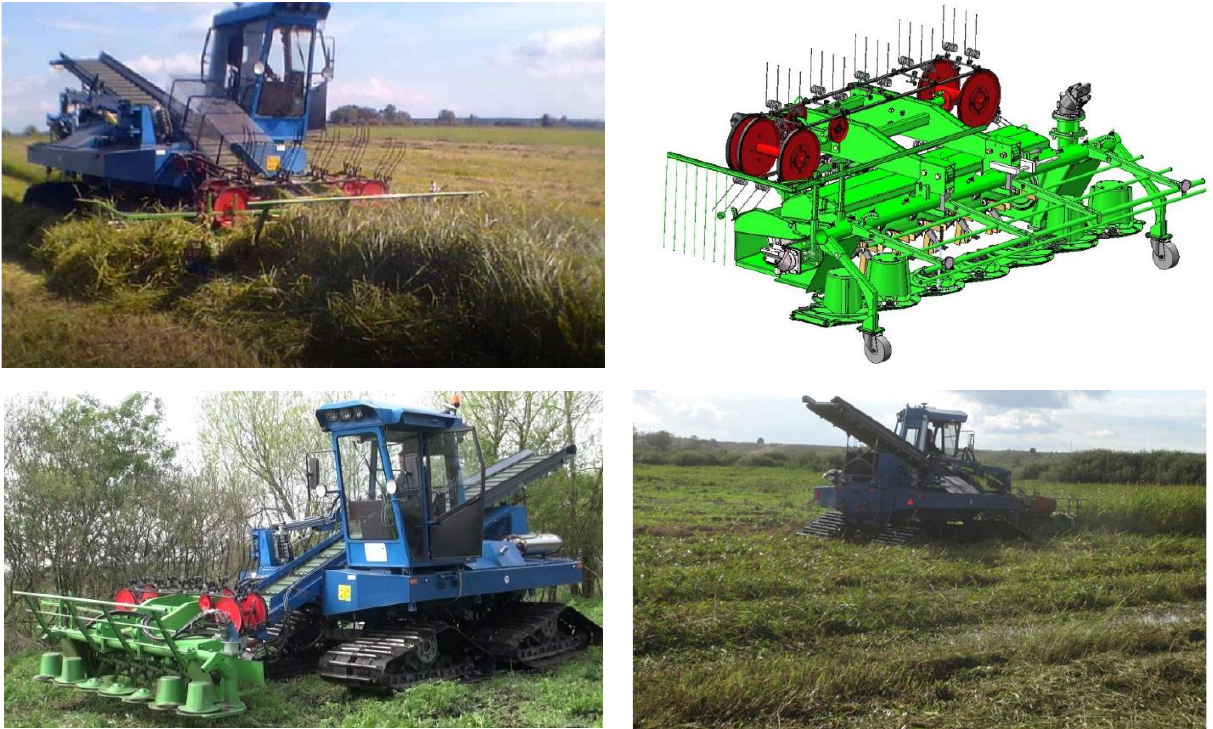
Figure 2. The front-mounted mower unit for cutting and conditioning biomass and forming swath. Top left: the disk mower with finger-wheel rake and tedder before upgrading. Top right: virtual model of the new mower unit with biomass conditioner designed by PIMR. Bottom left: real model of the new mower unit built by PIMR. Bottom right: the new mower unit during field testing on the wetlands at Biala village, where the delta tracks did not cause any damage to the top root layer of the plants. Photos: PIMR